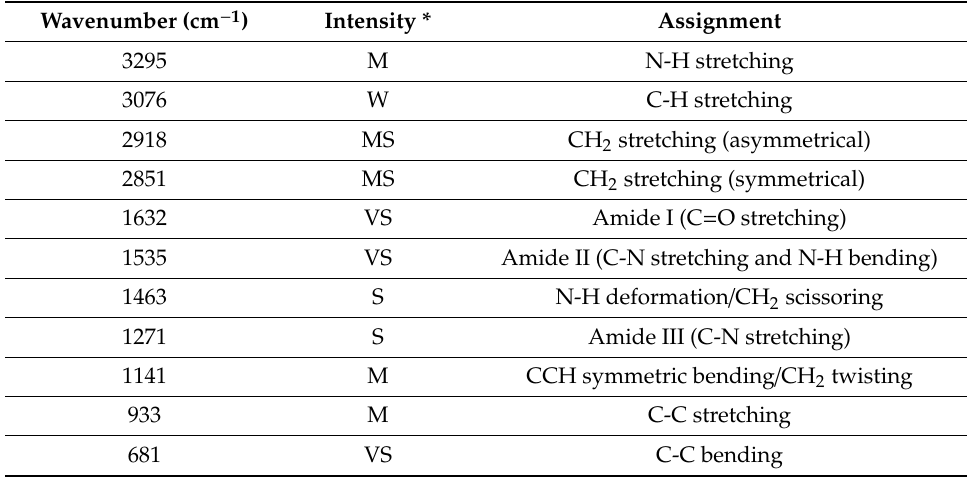
Table 5. FTIR assignment of bands observed in PA66 fibres with the wavenumber and type of signal. Adapted from [72–75].